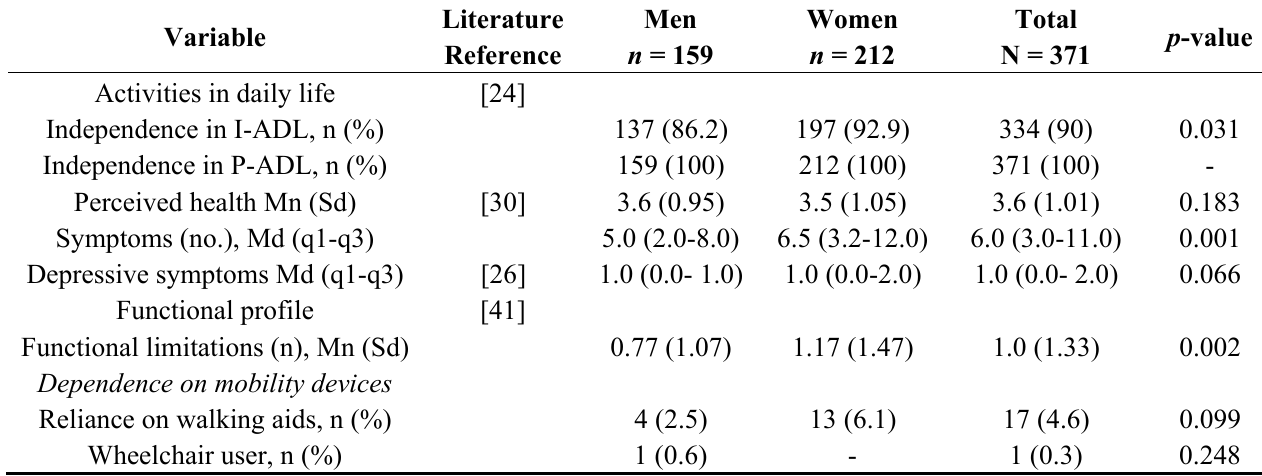
Table 3. Health variables and assistive devices for men and women in the study sample, N = 371.